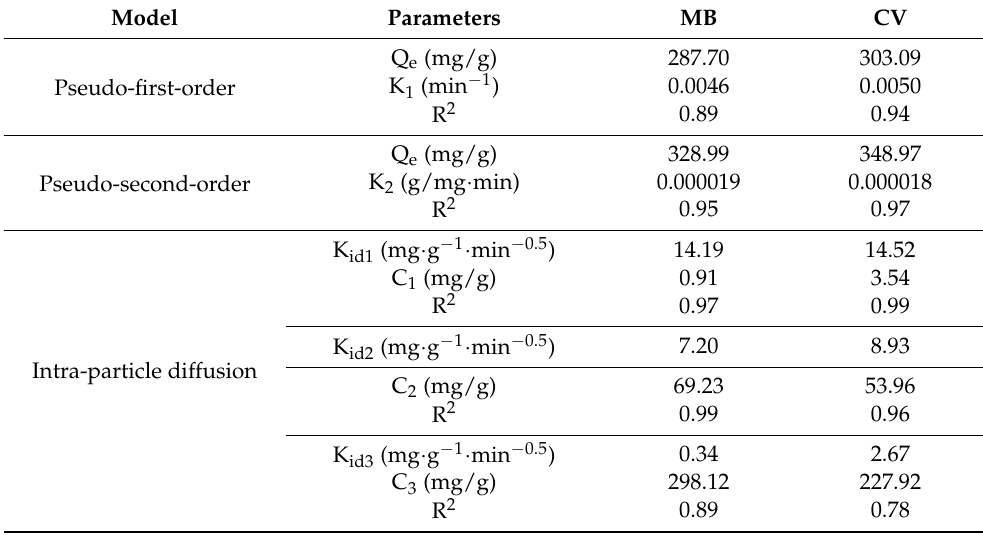
Figure 4. ( a ) The effect of contact time on the performance for the adsorption of MB and CV by MT. Adsorption kinetics for the adsorption of MB and CV by MT: ( b ) pseudo-first-order model, pseudo-second-order model, ( c , d ) intra-particle diffusion model. Table 2. Adsorption kinetics and intra-particle diffusion model parameters for the adsorption of MB and CV by MT.